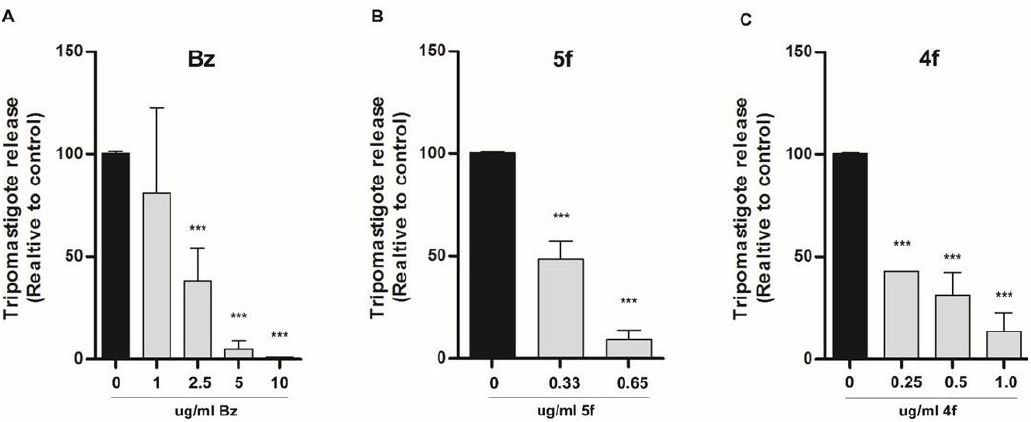
Figure 2. Hybrid activity on trypomastigote release at day six post infection. Cells treated with the indicated concentration of benznidazol ( A ) or the hybrids compounds 5f ( B ) or 4f ( C ). Bars indicate mean ± ES of at least three independent assays (see Methods) *** p < 0.001.